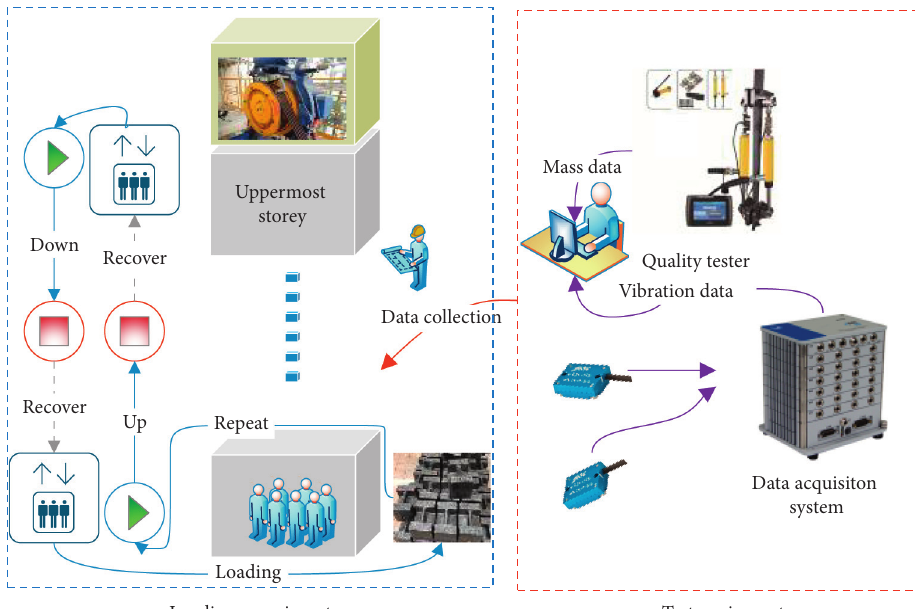
Figure 2: Testing process and experimental setup.